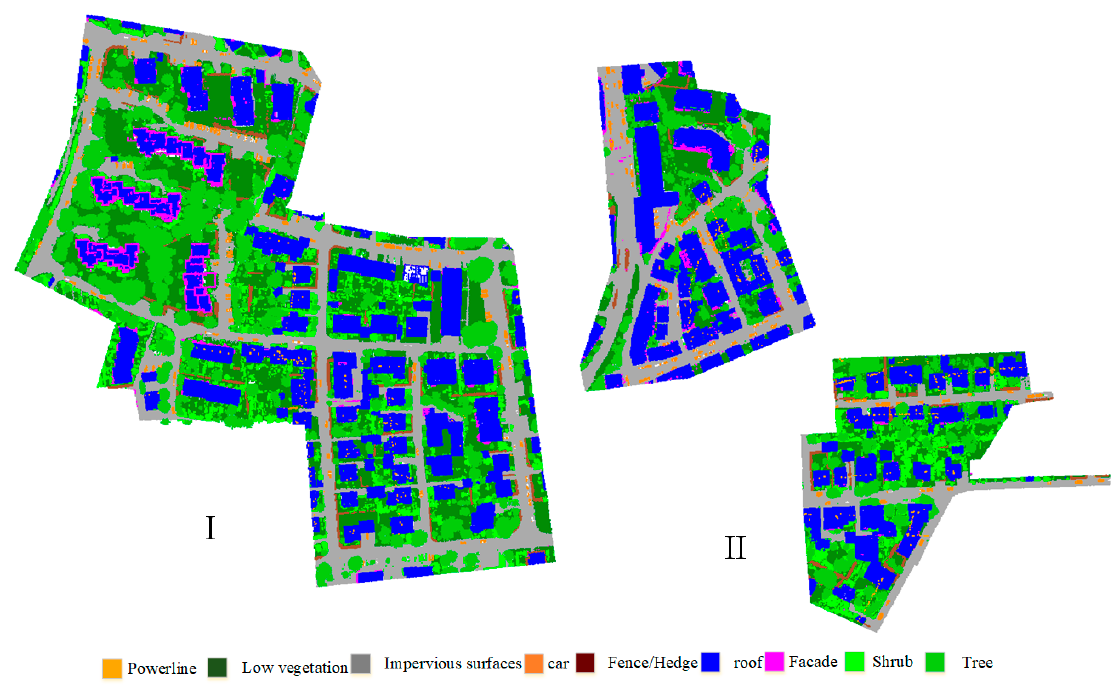
Figure 4. Scene I show the data for training and validation. Scene II is the test set. The following nine classes are discerned: power line, low vegetation, impervious surfaces, car, fence/hedge, roof, façade, shrub and tree.